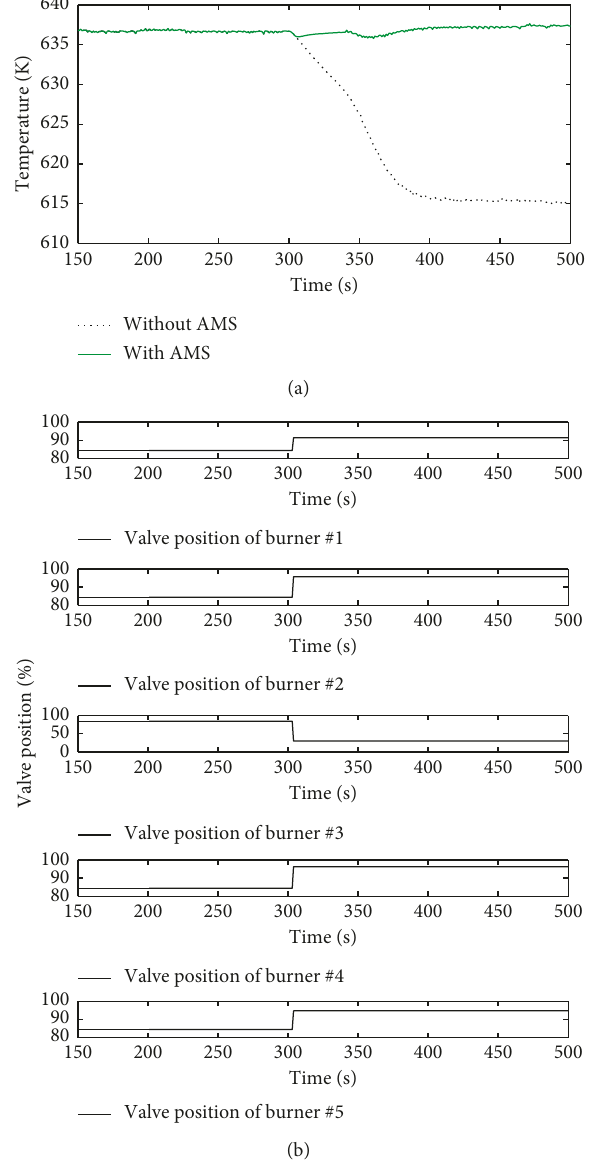
Figure 6: (a) Simulation result of the system. (b) Burner’s valve positions response when burner 3 lost 80% of its nominal heat